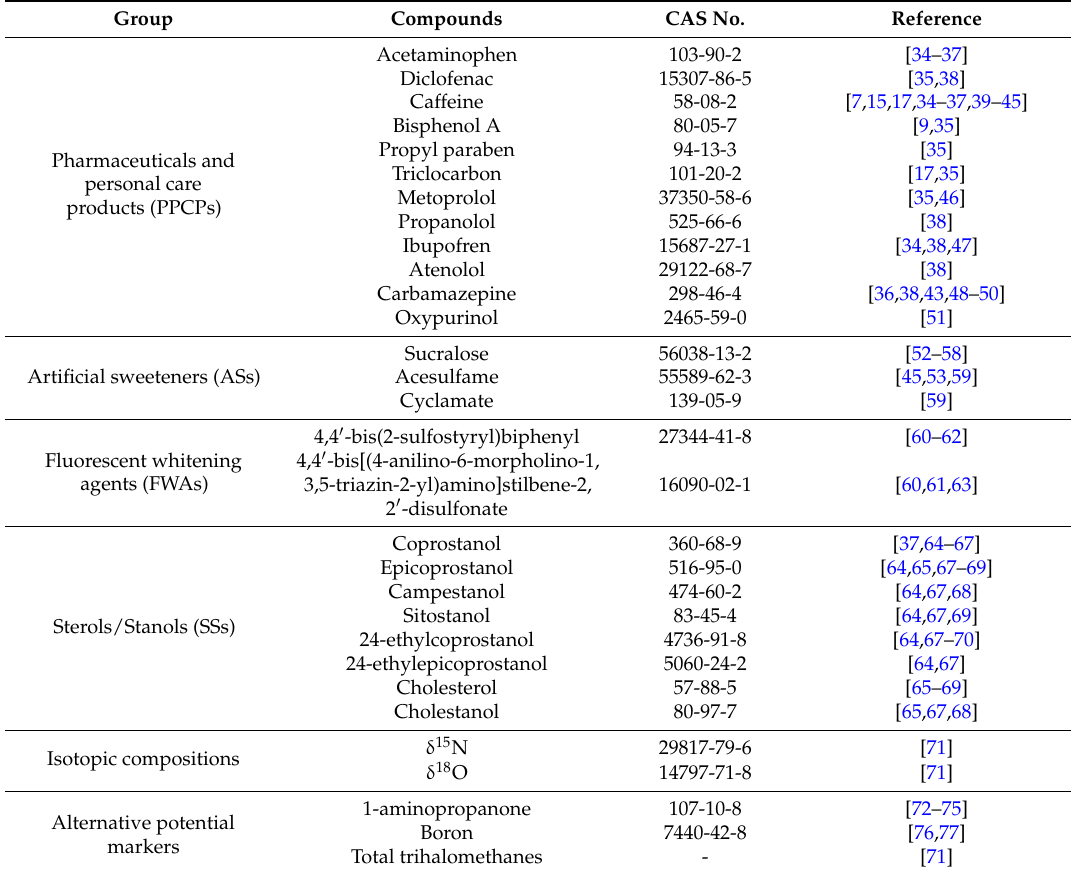
Table 1. Summary of chemical markers identified in the literature